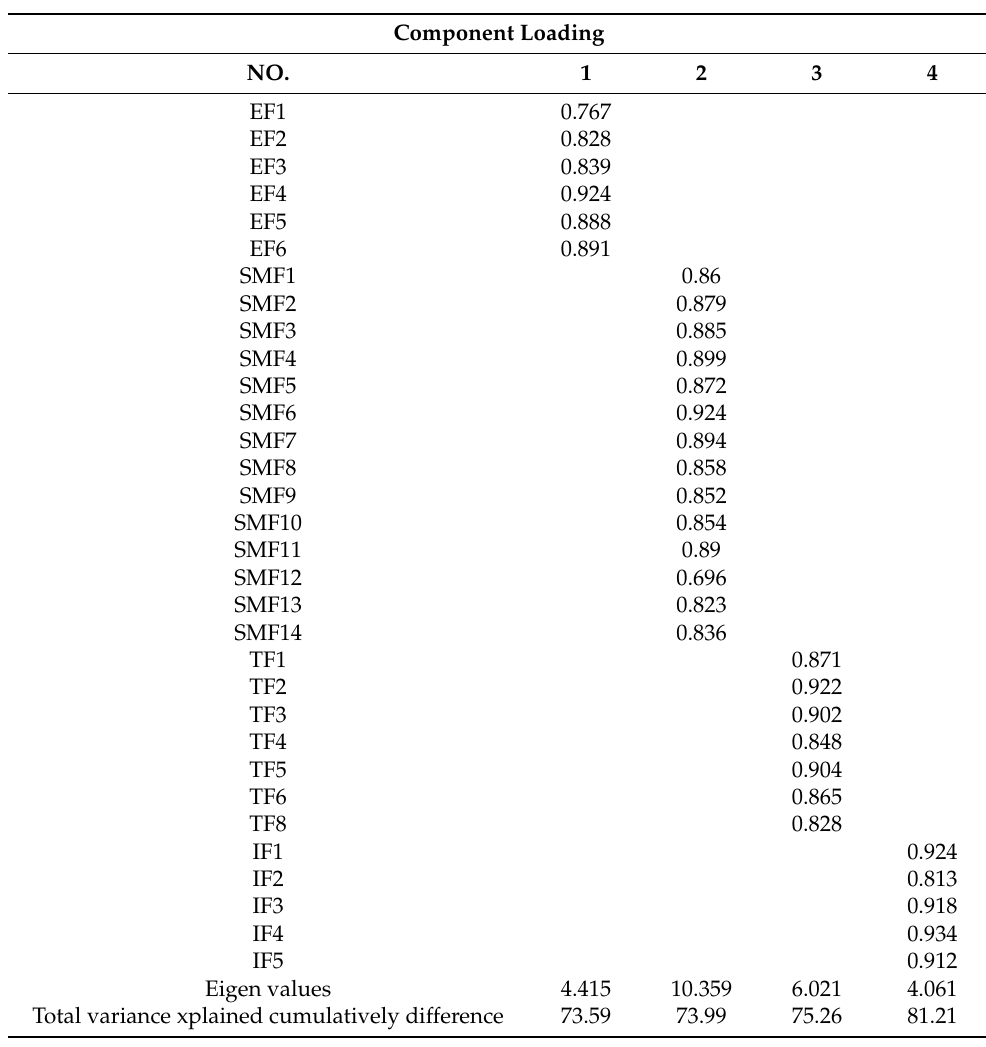
Table 4. Factor loading of VM obstacle